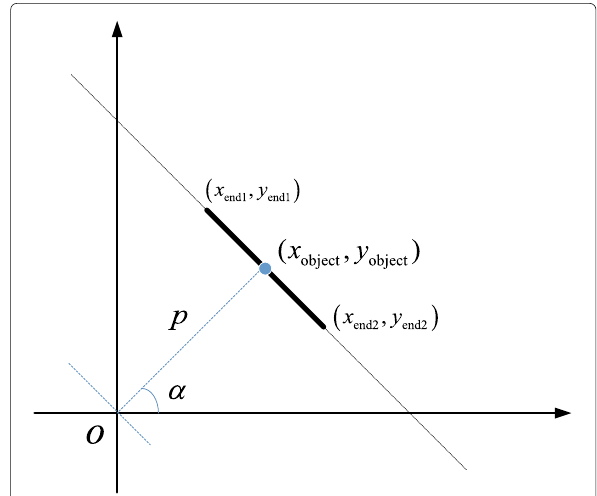
Fig. 6 Geometric representation of the typical object in polar